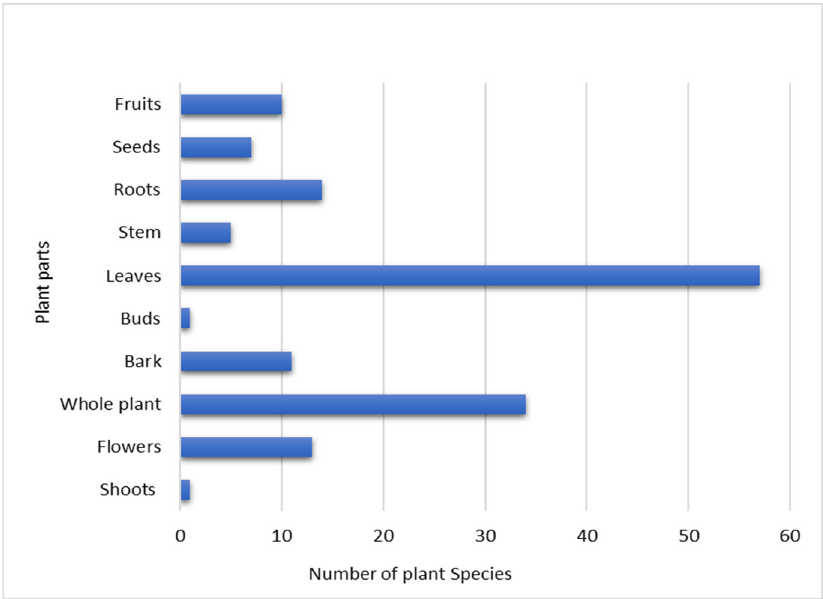
Figure 2. Graph showing the plant parts used for medicinal purposes and the number of plant species studied in the current